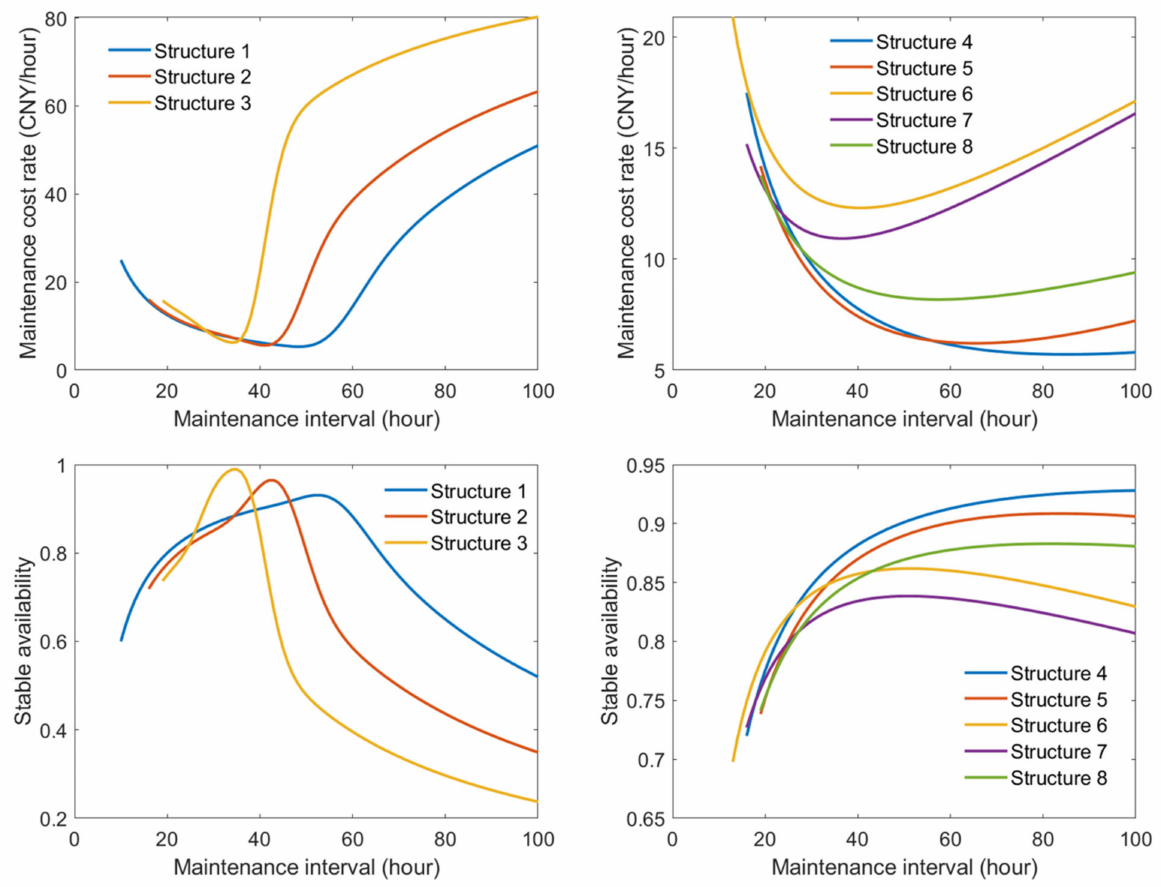
Figure 4. Variations in maintenance cost rate and stable availability with maintenance interval.